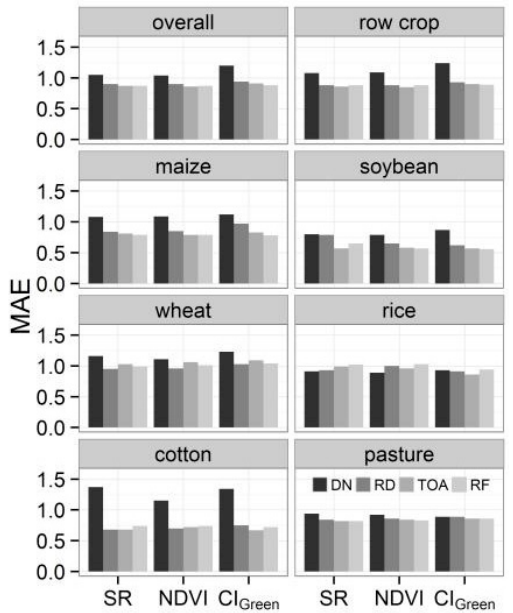
Figure 4. Mean Absolute Error (MAE) (cross validation) of the best-fit functions for different crops across levels of radiometric/atmospheric corrections. In the legend, RD presents for radiance, TOA is the Top-Of-Atmosphere reflectance, and RF is the surface reflectance. Note that EVI and EVI2 are not included in this figure, since these VIs can only be calculated from reflectance data.